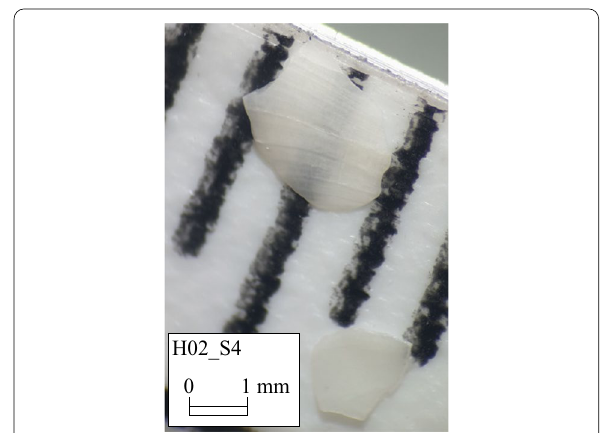
2017). Sand units S4, S5, S6, S7, S8, S9, and S10 can be con- sidered as clear marine-origin events, based on attrib- utes such as landward thinning, erosive basal contacts (Fig. 4), landward decrease in magnetic susceptibility value – indicating landward mineral gradation during the wave progression (Fig. 5), presence of diatoms of